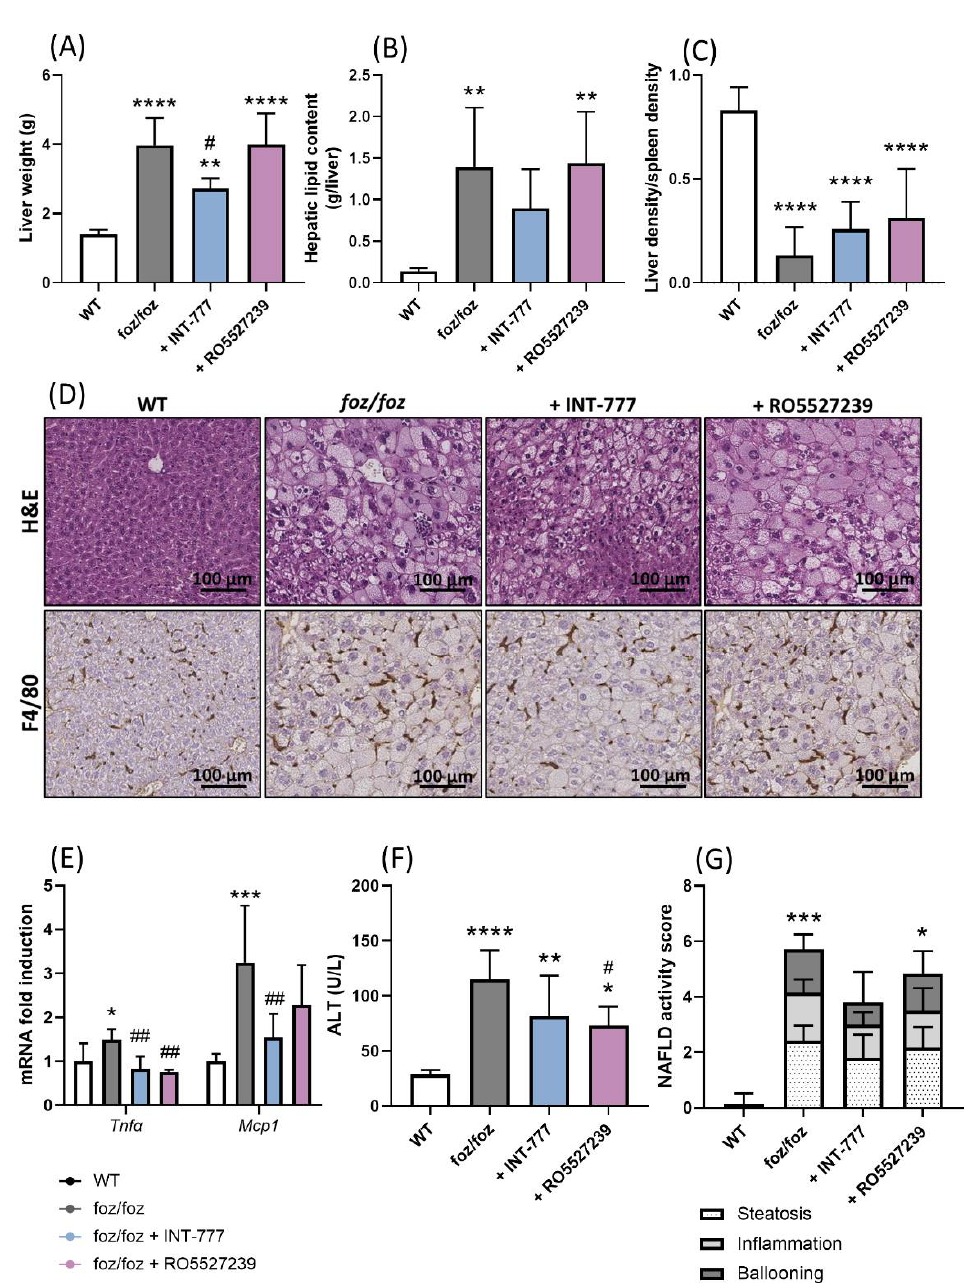
Figure 7. INT-777, but not RO5527239, partially improves NASH. Liver ( A ) weight, ( B ) lipid content, ( C ) density (normalized to spleen density). ( D ) Representative H&E and F4/80 staining of liver sections (bar size: 100 µ m). ( E ) Hepatic gene expression of Tnf α and Mcp1 , ( F ) plasmatic ALT levels and ( G ) NAFLD activity score [1] of WT, foz/foz , foz/foz + INT-777 and foz/foz + RO5527239 mice (n = 7/group). Mean ± SD. One-way ANOVA followed by post hoc Bonferroni correction. Statistical significance is represented by * p < 0.05; ** p < 0.01; *** p < 0.001 and **** p < 0.0001 when compared to WT; and # p < 0.05; ## p < 0.001 when compared to foz/foz . All p -values < 0.05 are represented on the graphs, while p -values > 0.05 are not.